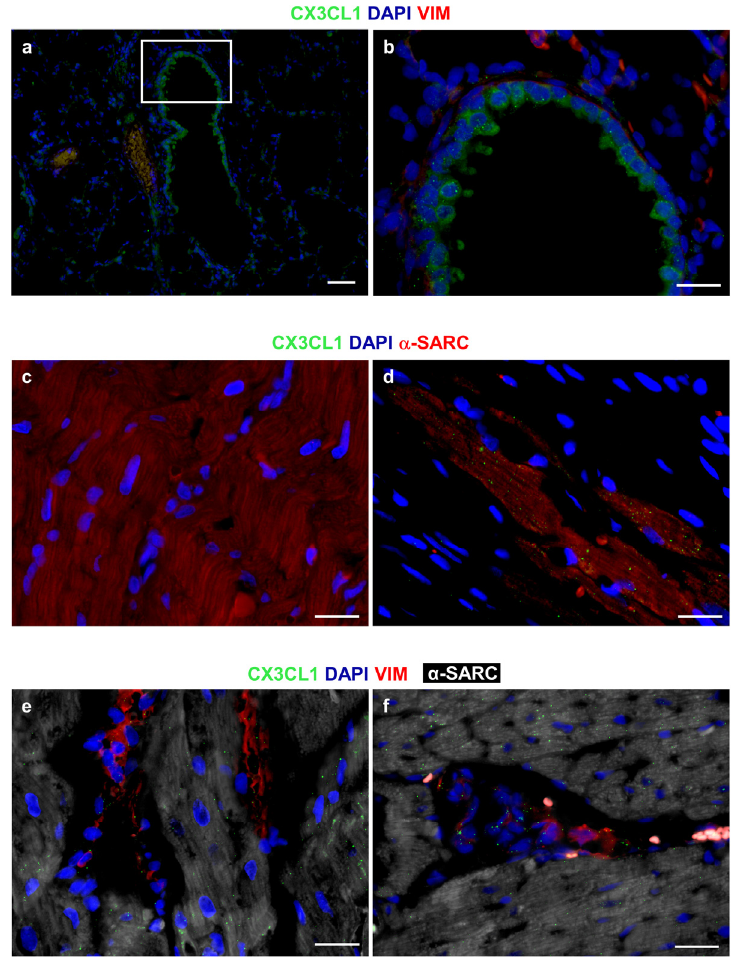
Figure 5. Immunofluorescence analysis of CX3CL1 (Fractalkine). The granular and diffuse cytoplasmic expression of CX3CL1 (green) is apparent in bronchiolar epithelial cells of the rat lung, used as a positive control tissue; ( a , b ) The white square includes an area shown at higher magnification in b where interstitial cells are depicted by the red fluorescence of vimentin (VIM); ( c ) Internal negative control. Absence of immunofluorescence signals in a section of the rat diabetic heart exposed to FITC secondary antibodies in the absence of primary anti ‐ CX3CL1 antibodies. Cardiomyocytes are recognized by the red fluorescence of alpha ‐ sarcomeric actin ( α‐ SARC); ( d ) A rather dense granular, dot ‐ like pattern of CX3CL1 (green) expression in α‐ SARC (red) positive cardiomyocytes is illustrated in a section of the rat infarcted myocardium; ( e , f ) A granular, dot ‐ like expression of Fractalkine (green) is apparent in VIM (red) positive fibroblasts and interstitial cells surrounding α‐ SARC (withe) positive cardiomyocytes. The pro ‐ inflammatory cytokine is also detectable in cardiomyocytes. ( a – f ): Blue fluorescence corresponds to DAPI staining of nuclei. Scale Bars: ( a ) = 50 μ m, ( b – f ) = 20 μ m.